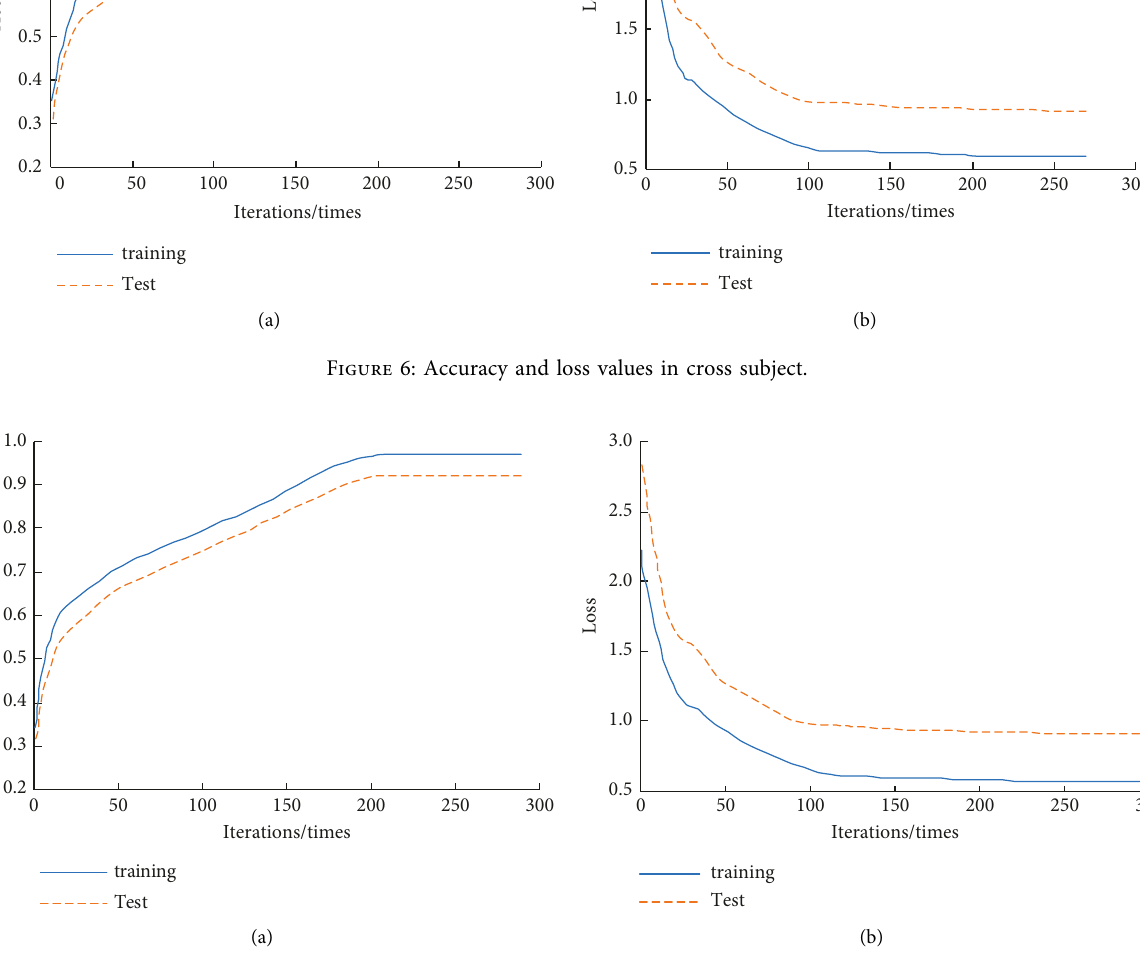
Figure 7: Accuracy and loss values in cross